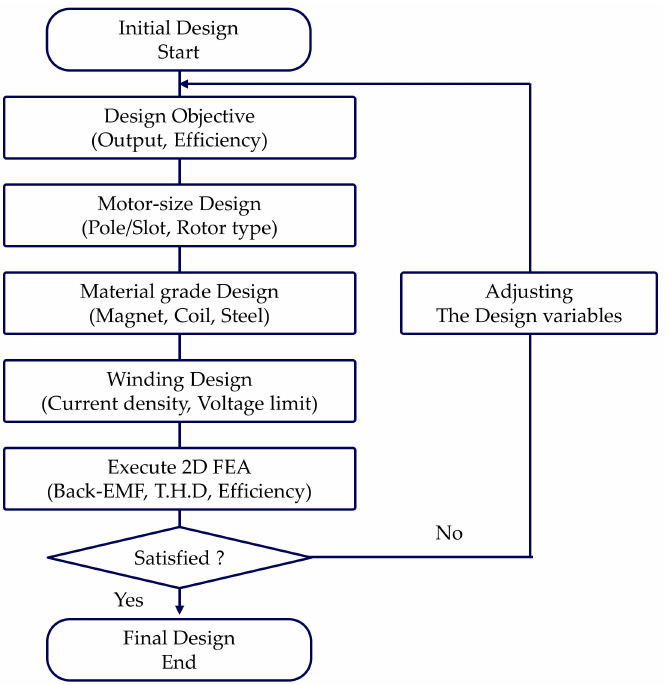
Figure 8. Design process of IPM